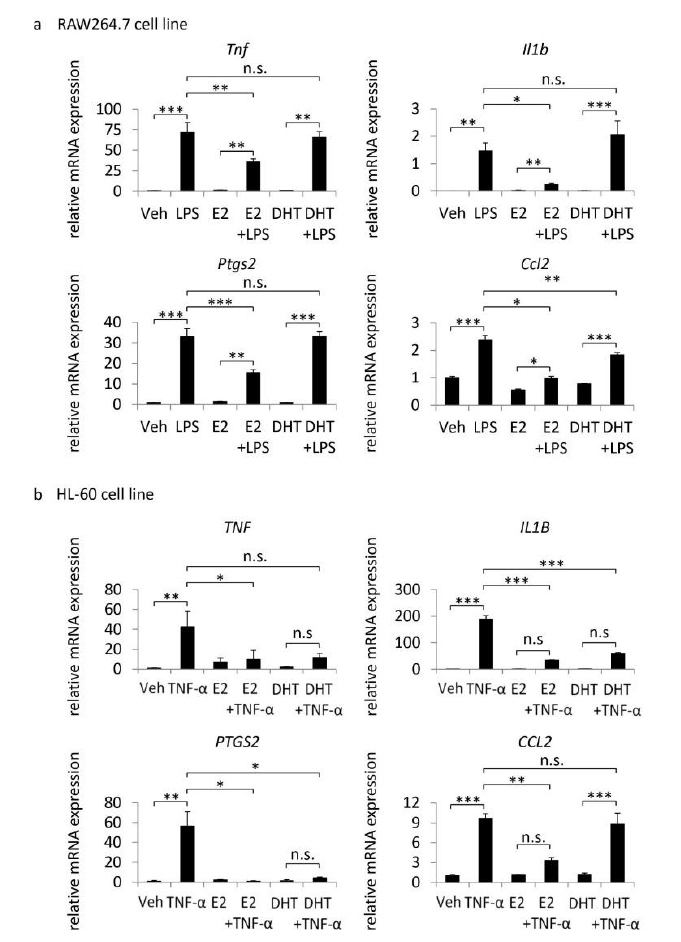
Figure 4. Suppressive effect of the sex hormone on expressions of pro-inflammatory genes in cultured macrophages or neutrophils. RAW264.7 cells ( a ) or HL-60 cells ( b ) were pre-treated with β-estradiol (E2, 50 µg/mL) or 5α-dihydrotestosterone (DHT, 50 µg/mL) for 24 h or 3 h, respectively. Cells were then stimulated with vehicle (Veh), LPS (dose) or TNF-α (dose) for an additional 60 min. Expressions of pro-inflammatory genes were examined by quantitative RT-PCR analyses. Bars indicate the mean ± SEM ( n = 4). Statistical analysis was done by a Tukey-Kramer method. *; p < 0.05, **; p < 0.01, ***; p < 0.001. n.s.; statistically not significant.